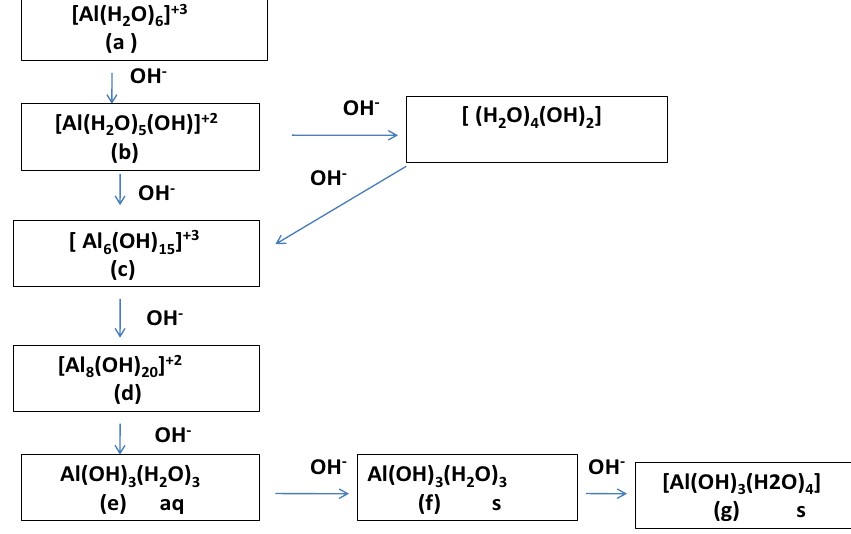
Fig. 1 Stepwise conversion of the tri-positive aluminum ion to the negative aluminate ion